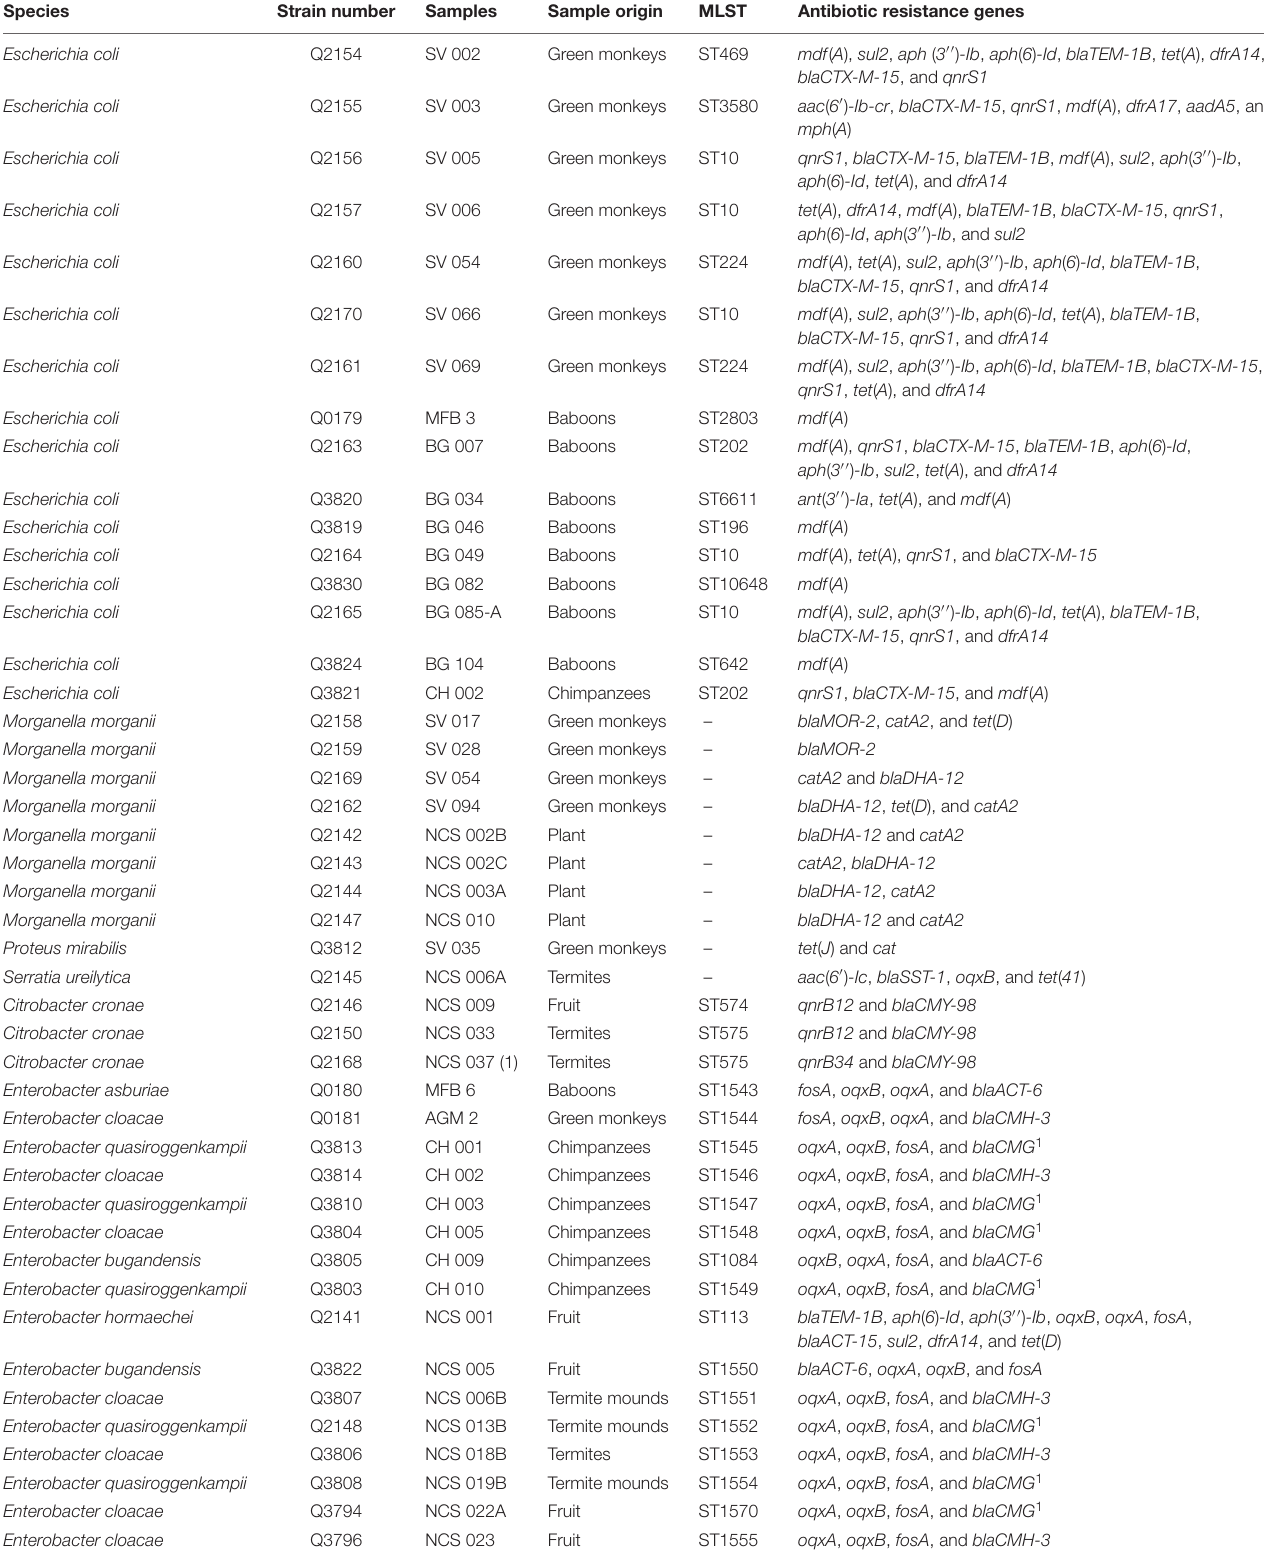
TABLE 1 | Summary of antibiotic resistance genes in isolates of interest.